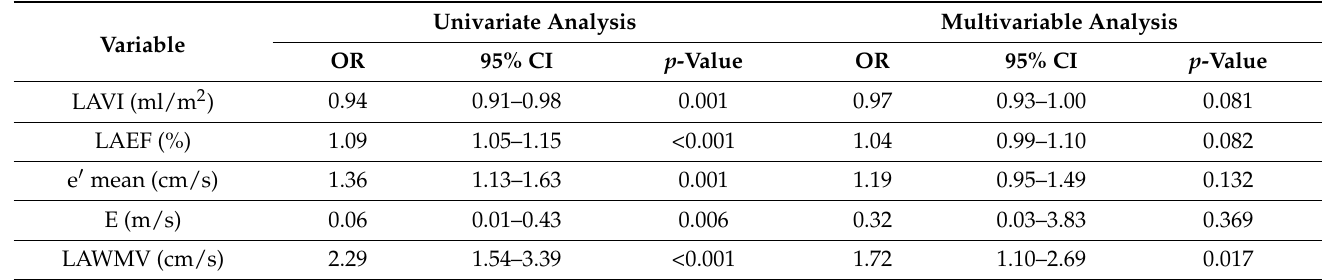
Table 4. Multivariate regression analysis including echocardiographic variables.